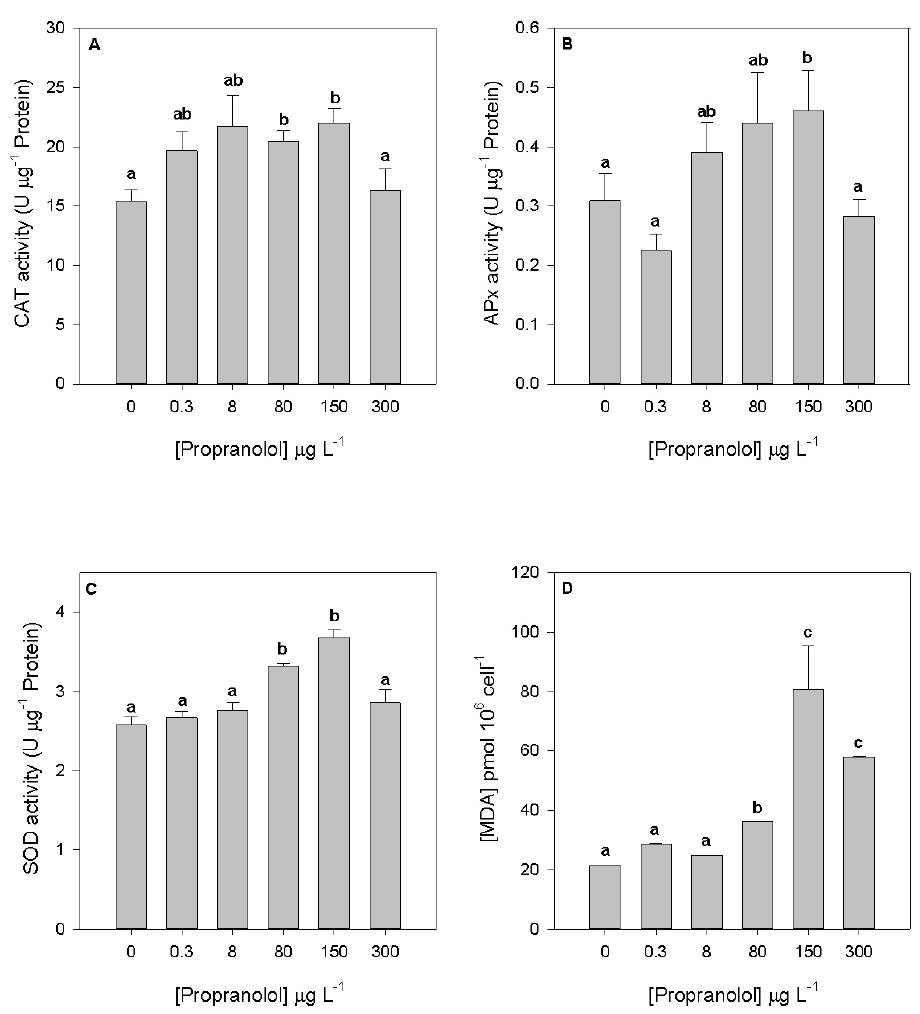
Figure 7. Catalase ( A ), ascorbate peroxidase ( B ), superoxide dismutase ( C ) activities and lipid peroxidation products ( D ) in Phaeodactylum tricornutum cultures exposed to different propranolol concentrations (average ± standard error, n = 3, letters denote differences at p < 0.05).